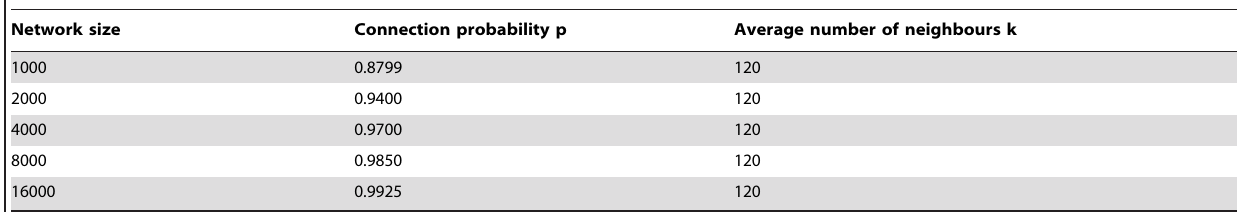
Table 2. Connection probability and network size.